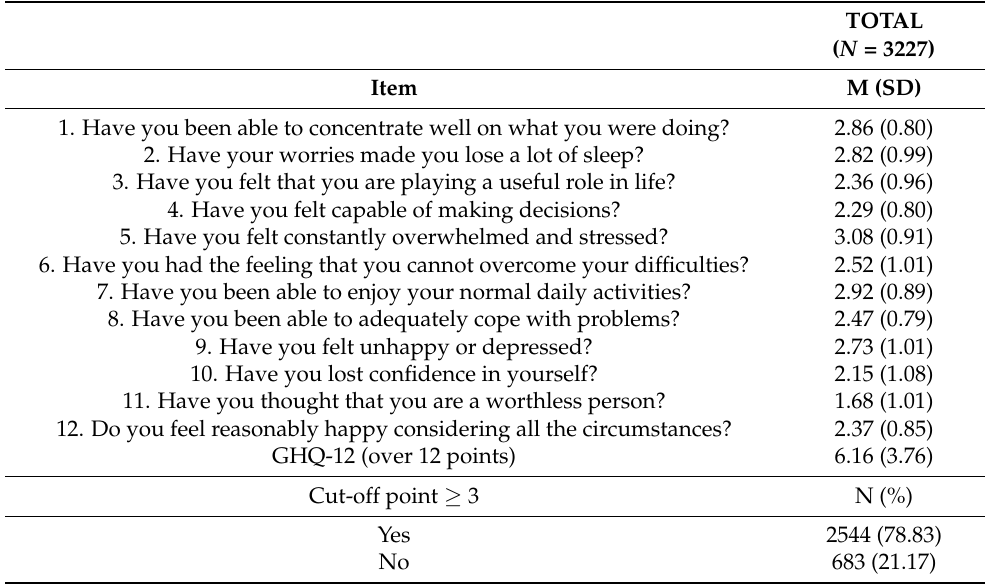
Table 2. Psychological Distress: General Health Questionnaire